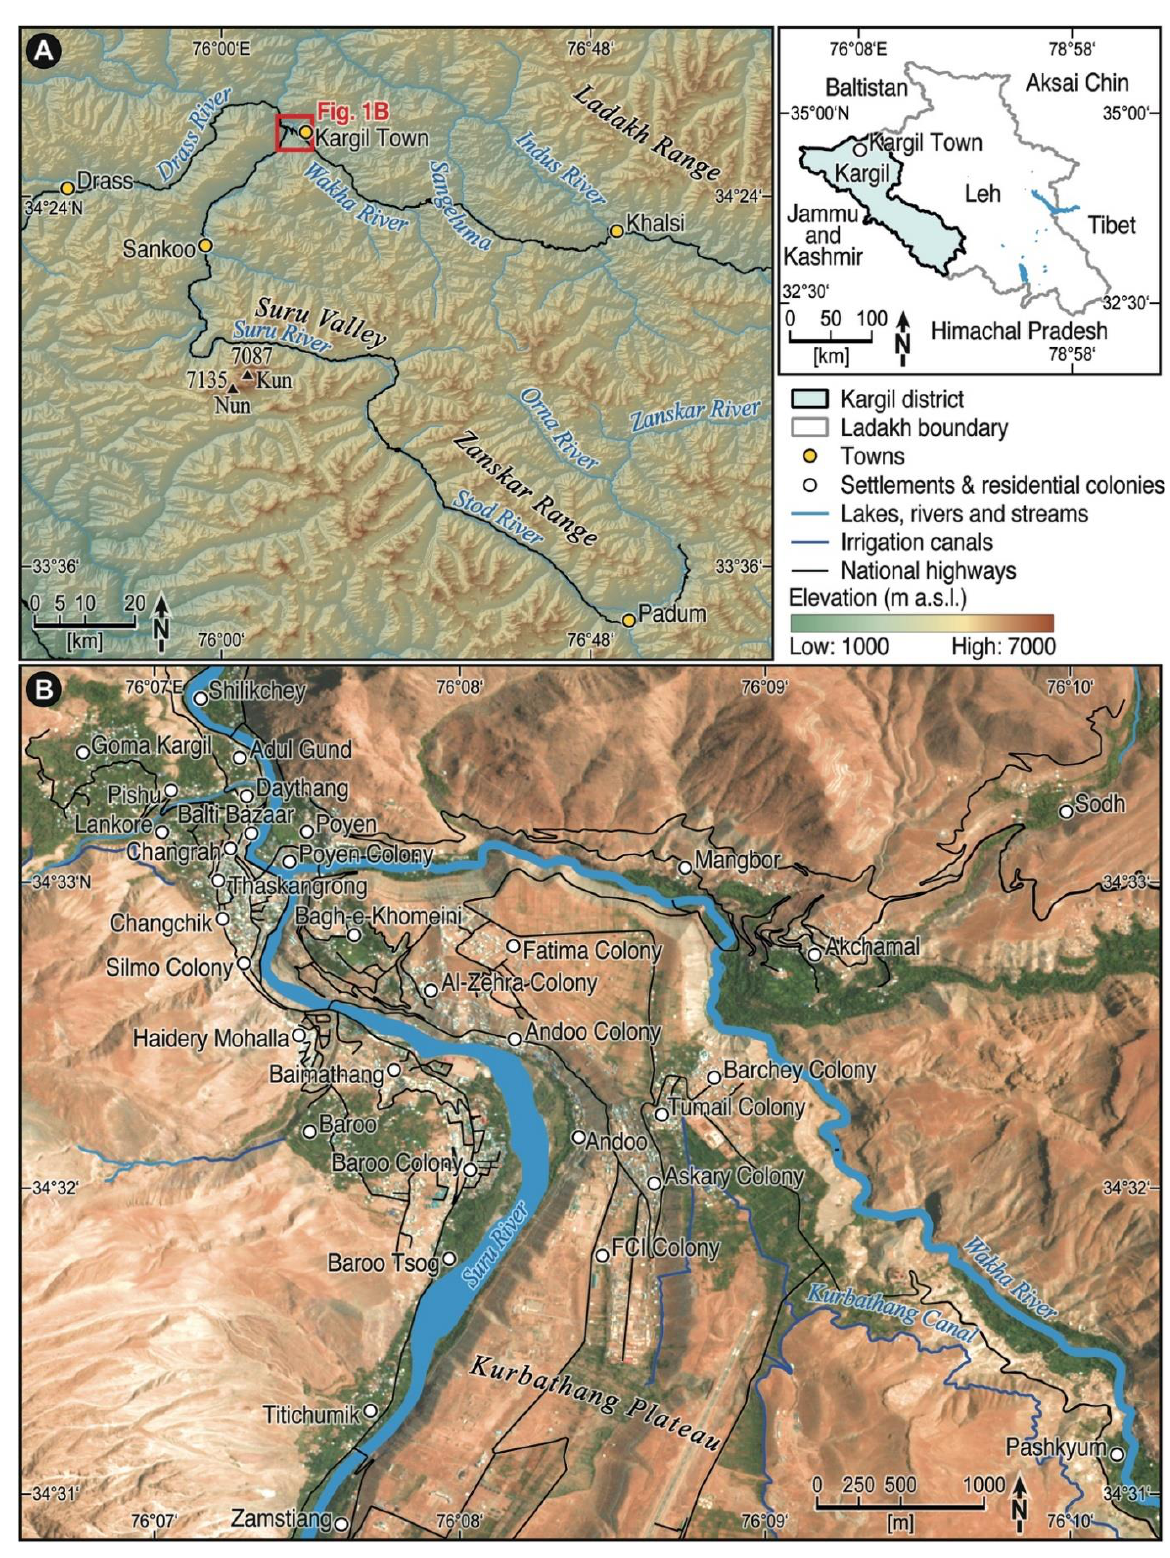
Figure 1. ( A ) Location of Kargil town in Ladakh and ( B ) detailed distribution of settlements and residential colonies of Kargil town (Source: PlanetScope (8 June 2020); SRTM (11 February 2000);